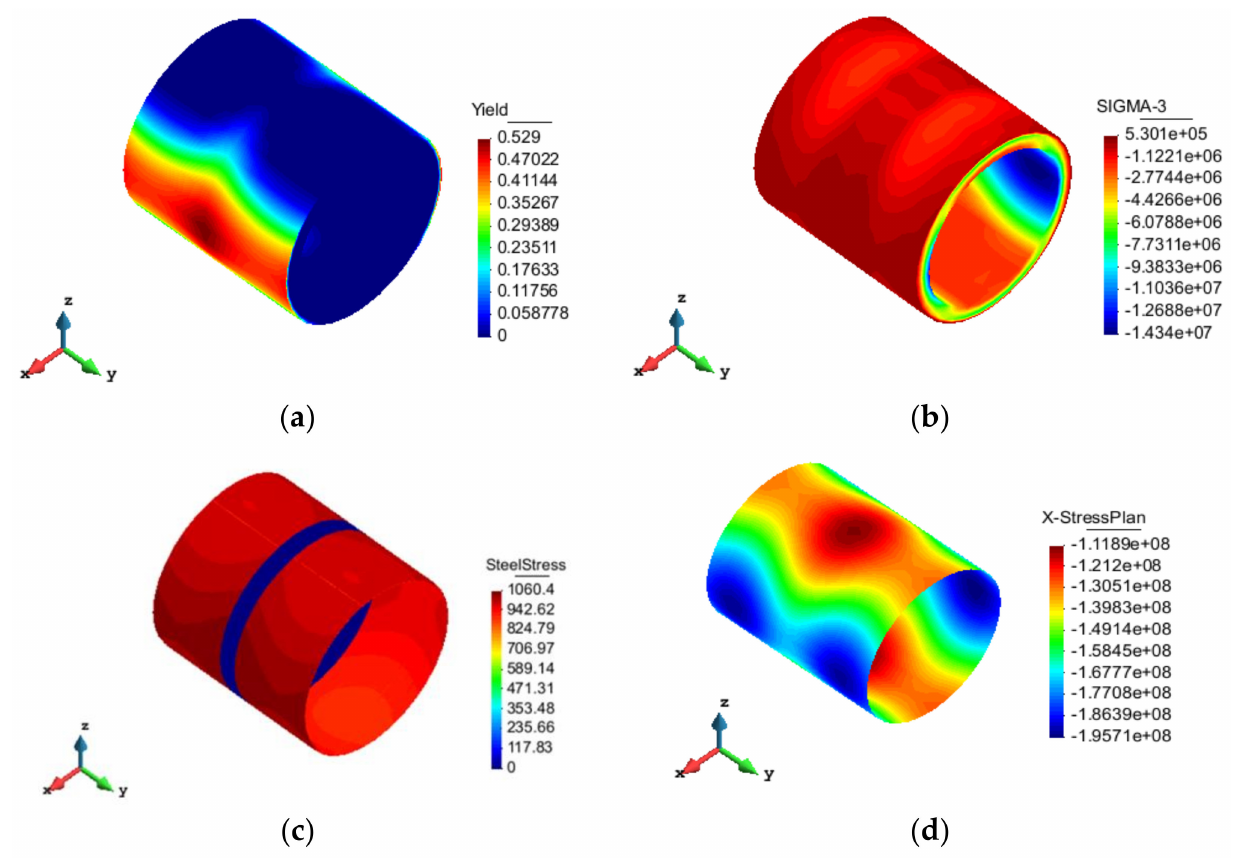
Figure 11. Nephogram of case 3: ( a ) damage, ( b ) 3rd principal stress, ( c ) wire stress, ( d ) cylinder stress.